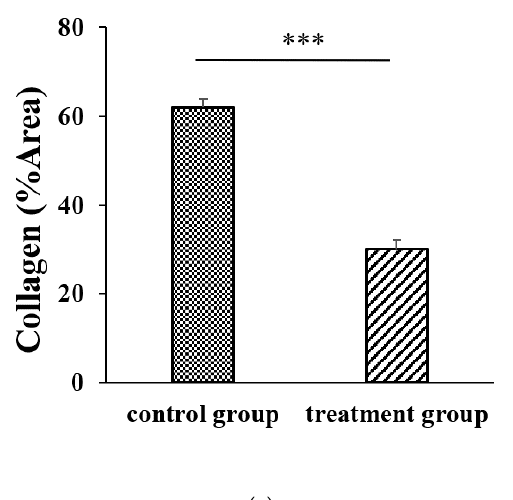
Figure 2. Fibrotic effects of AR12286 on post-trabeculectomy bleb tissue. Histological examination of bleb tissue from ( a ) control group (without AR12286) and ( b ) treatment group (injected with AR12286) of experimental rabbit trabeculectomy models. Collagen deposition (blue) examined using Masson’s trichrome stain ( a ). On Day 8 post-surgery, less intense blue stain was evident in the bleb tissue compared with that in the control group, indicating that AR12286 reduced collagen deposition in bleb tissue. ( c ) Ratios of collagen-fiber areas to conjunctival and scleral lesions in control and treated eyes. Values represented as means ± SEM ( n = 6). *** indicates p < 0.001 compared with controlled eyes.